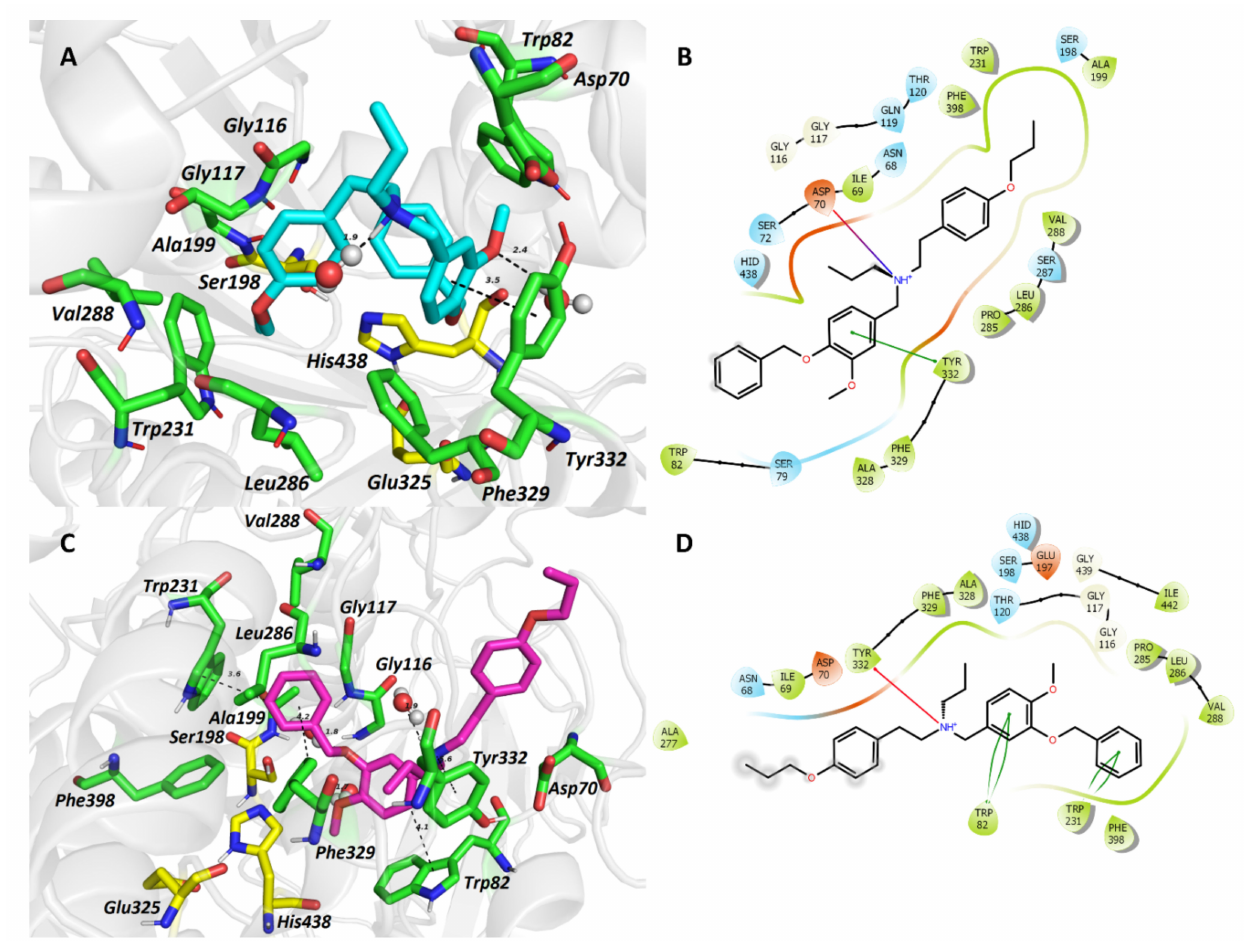
Figure 3. The top-scored docking poses of ligands 5 ( A , B ) and 6 ( C , D ) in the h BuChE active site (PDB ID: 6QAA) [43] from MD simulation. The ligands are displayed in light blue ( 5 , A ) and purple ( 6 , C ); important amino acid residues responsible for ligand anchoring are shown in green. Catalytic triad residues are displayed in yellow. Important interactions are rendered by black dashed lines; distances are measured in Ångstroms (Å). The rest of the receptor is displayed in light-grey cartoon conformation ( A , C ). Figures ( A , C ) were created with The PyMOL Molecular Graphics System, Version 2.4.1, Schroödinger, LLC. Two-dimensional figures ( B , D ) were generated with Maestro 12.3 (Schrödinger Release, Schrödinger, LLC, New York, NY, USA,